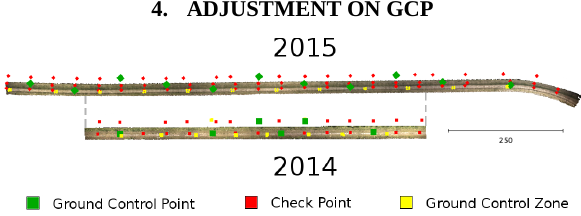
Figure 4: Dataset 2014 is split up into 3 : one strip made of vertical images (left), 2 strips of vertical images (central), and a mix of vertical and oblique images acquired on two strip (right). While oblique image are crucial when working with the classical camera model, the three steps auto-calibration process presented can be efficiently used in degenerate cases.